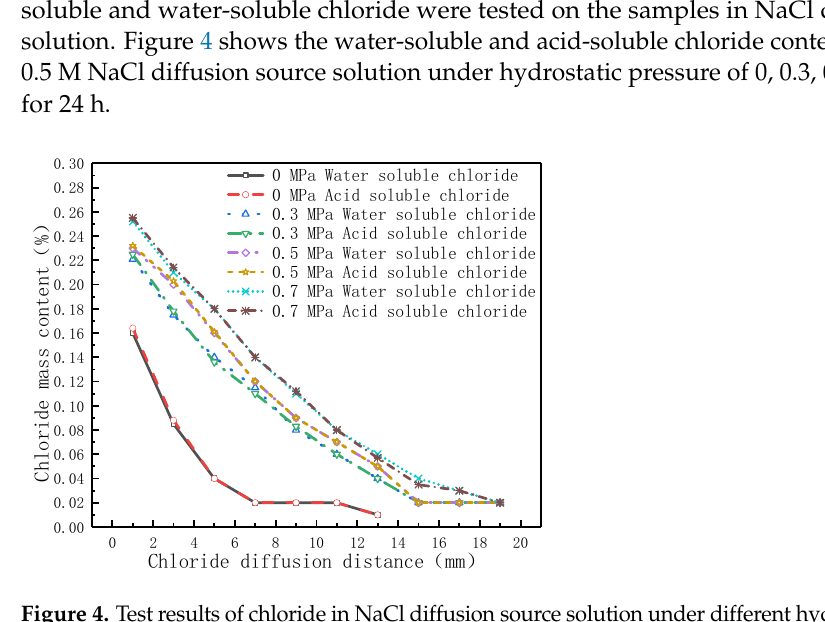
Table 5. Chloride diffusion coefficient in pressurized diffusion source solutions (0.5 M Cl − ).